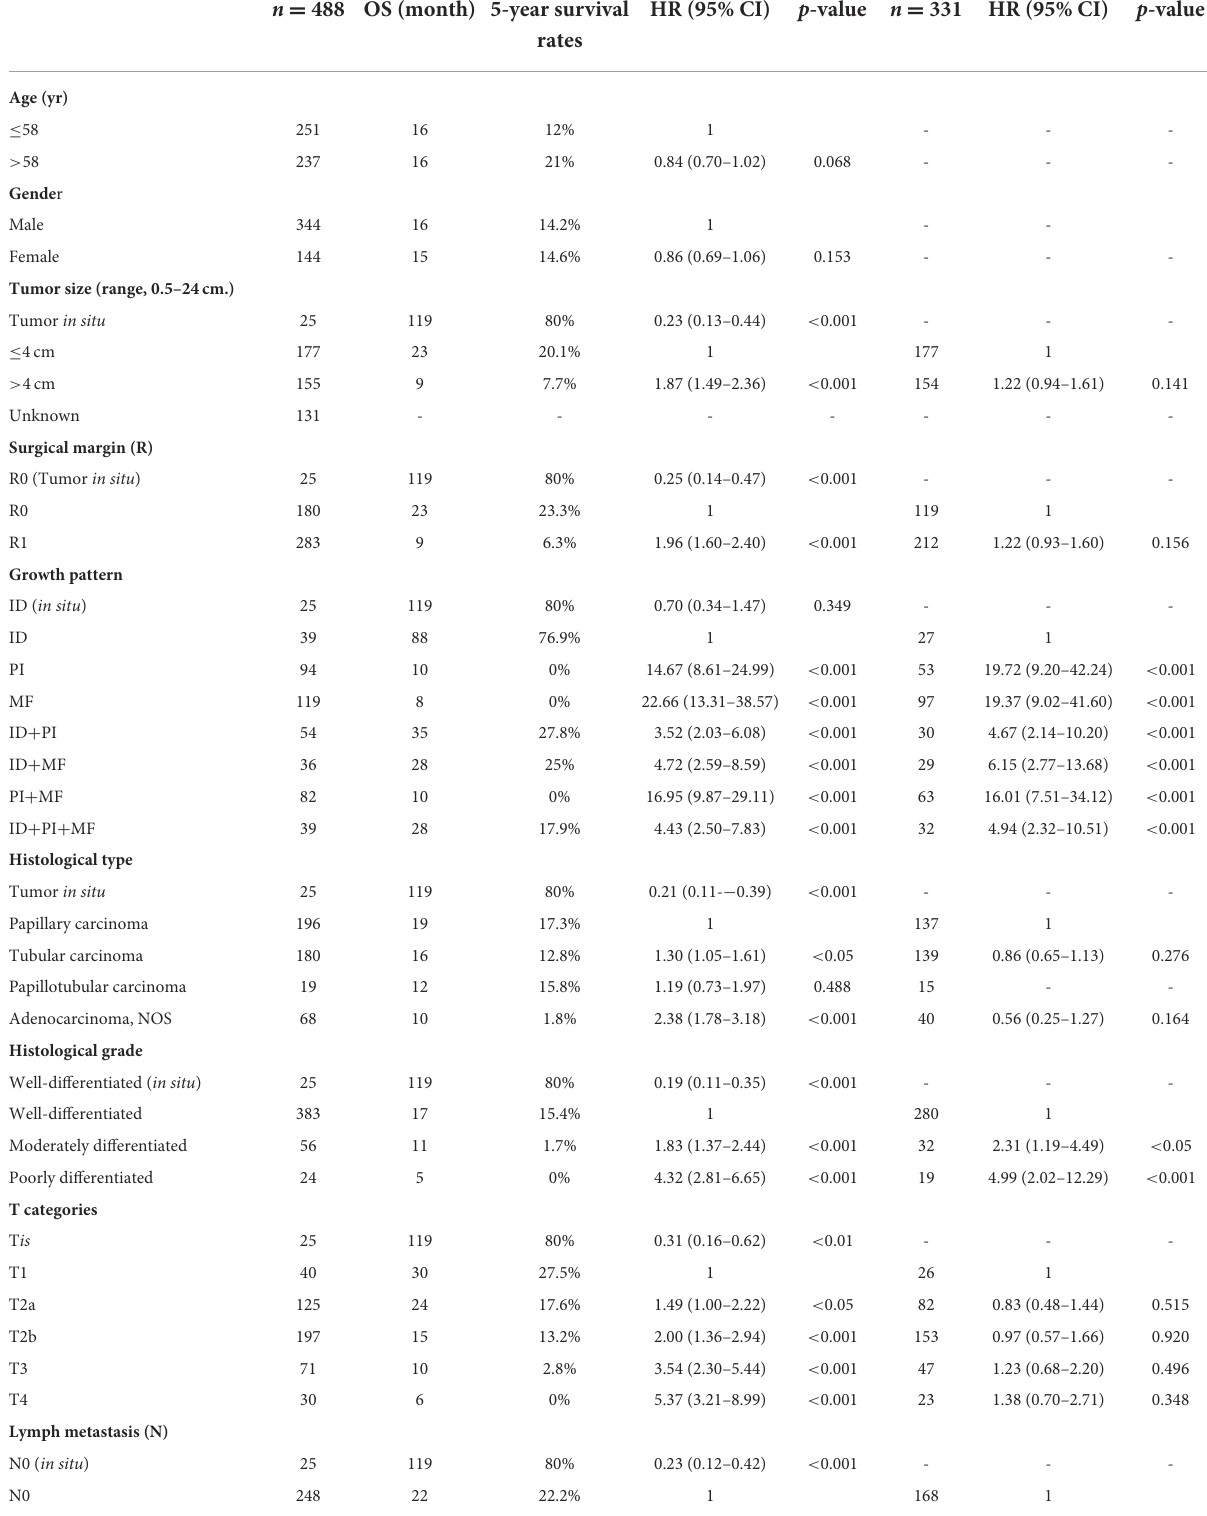
TABLE 3 Univariate and multivariate analyses of survival in patients with perihilar cholangiocarcinoma. Feature Univariate